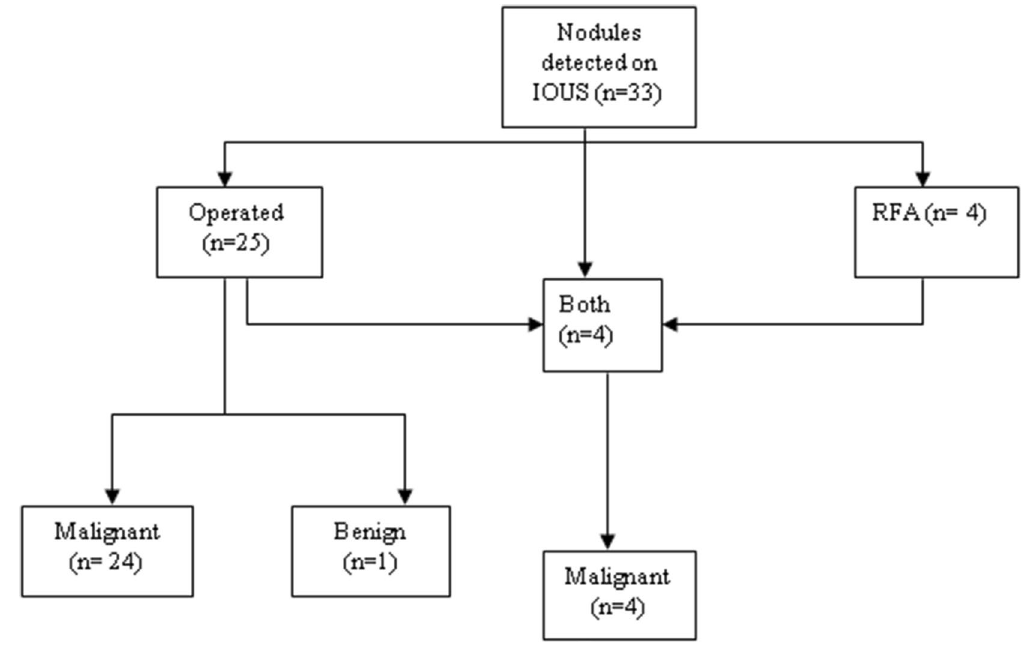
Figure 2. Indeterminate nodules detected on